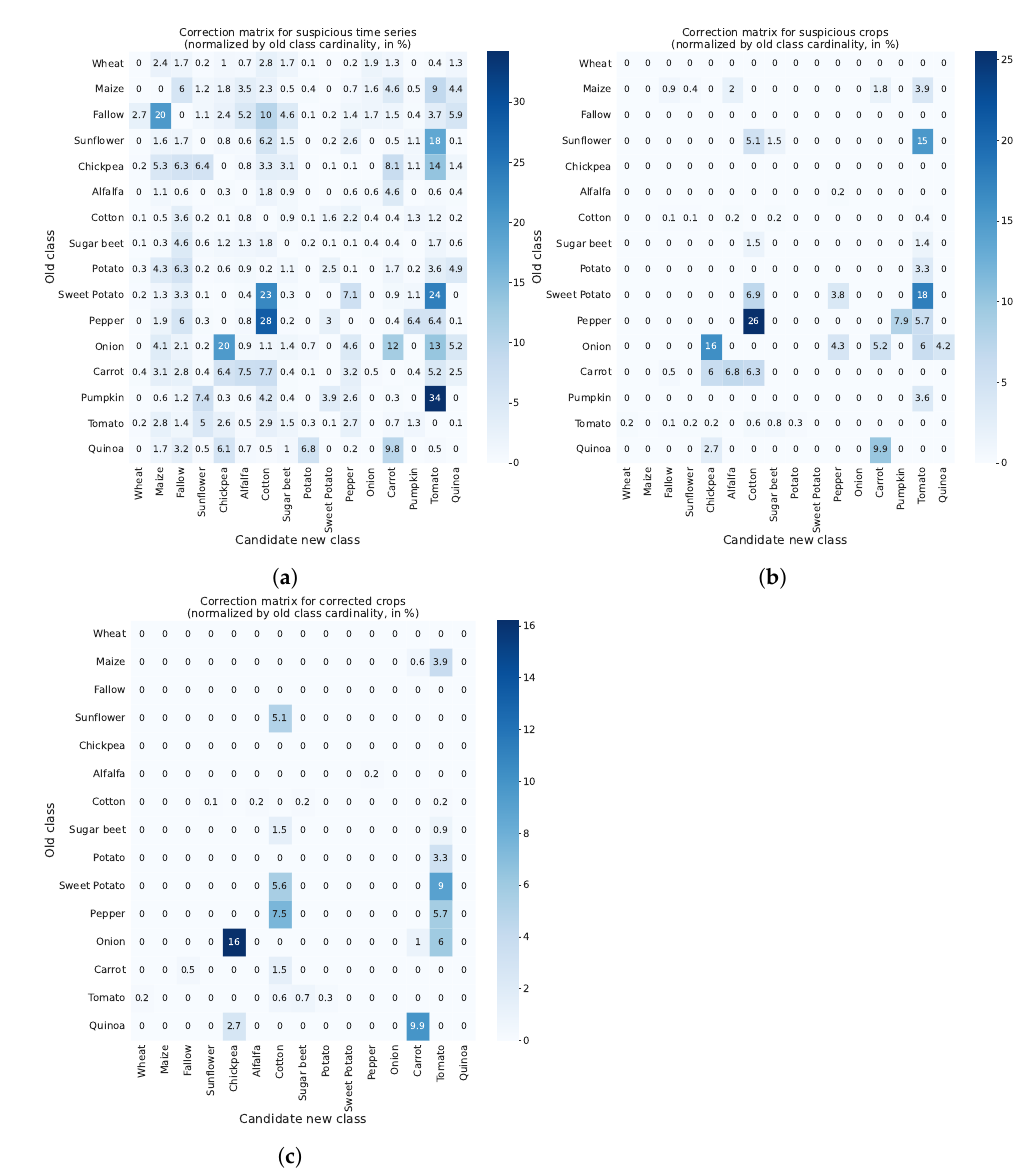
Figure 15. State of suspect crops and time series classes at every step of the method. Classes are displayed only for suspect crops/time series, for ease of visualization. Other crops are shown in gray. ( a ) Relabeling matrix at the first step of FARMSAR: time series relabeling (in percentage). ( b ) Relabeling matrix at the second step of FARMSAR: crop relabeling (in percentage) (no Otsu Thresholding applied). ( c ) Relabeling matrix at the second step of FARMSAR: crop relabeling (in percentage) (Otsu Thresholding